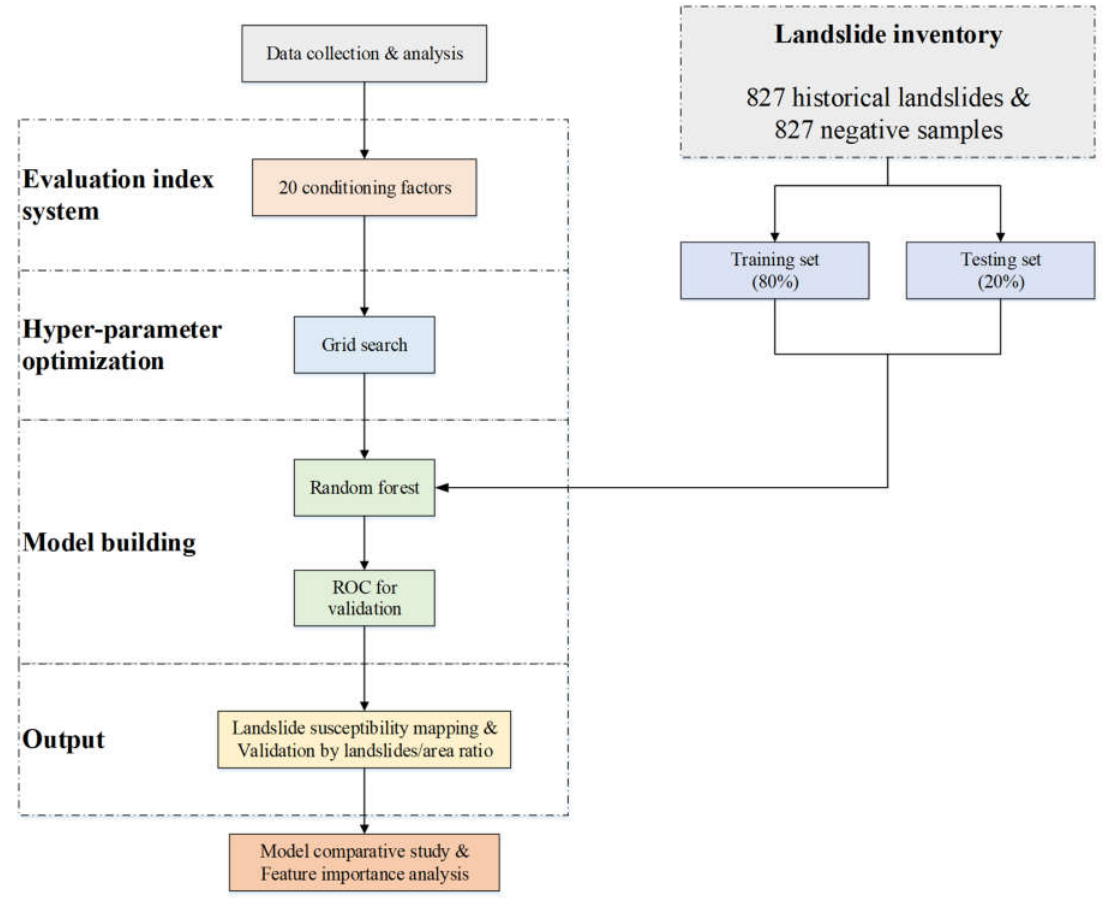
Figure 5. Flowchart of this